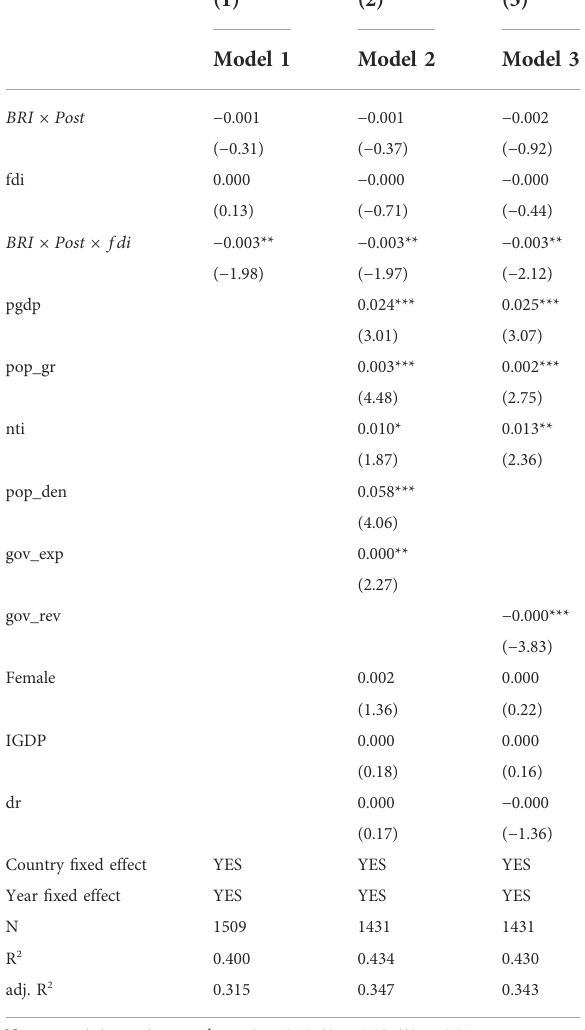
TABLE 16 Effects of the Belt and Road Initiative on environmental quality: Mechanism